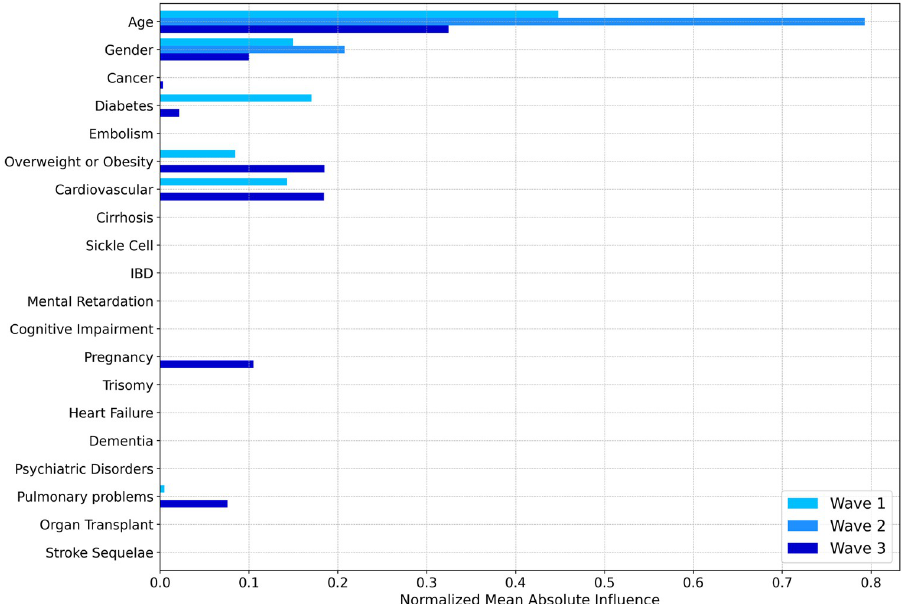
Fig 2. Global variable importance for each wave. Global Importance value indicates how important a feature in a particular wave is. As influences can be either positive or negative depending on the patient, Global Importance value for a feature and a wave is computed by averaging the absolute influence for that feature over all patients from the wave, then normalizing by the sum of all Global Importance feature values from the wave. Thus the sum of Global Importance values over a single wave is equal to